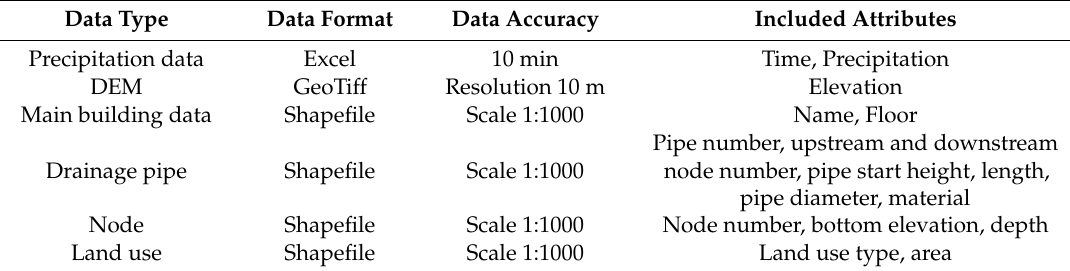
Table 3. Experimental area basic data summary table.